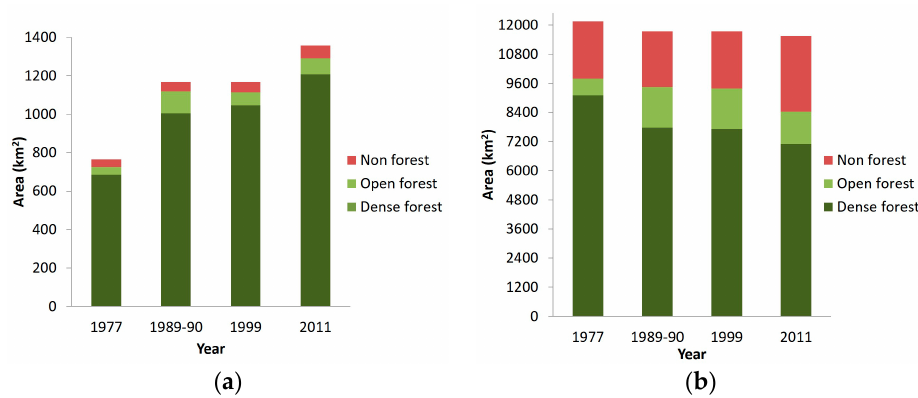
Figure 4. Change in dense forest, open forest, and non-forest in the forests ( a ) inside categories of strict protection (TR, WLS, NP, and BZ) and ( b ) outside categories of strict protection (RF, PF, and FDCM). Table 5. Change in forest cover percentage over time across different management